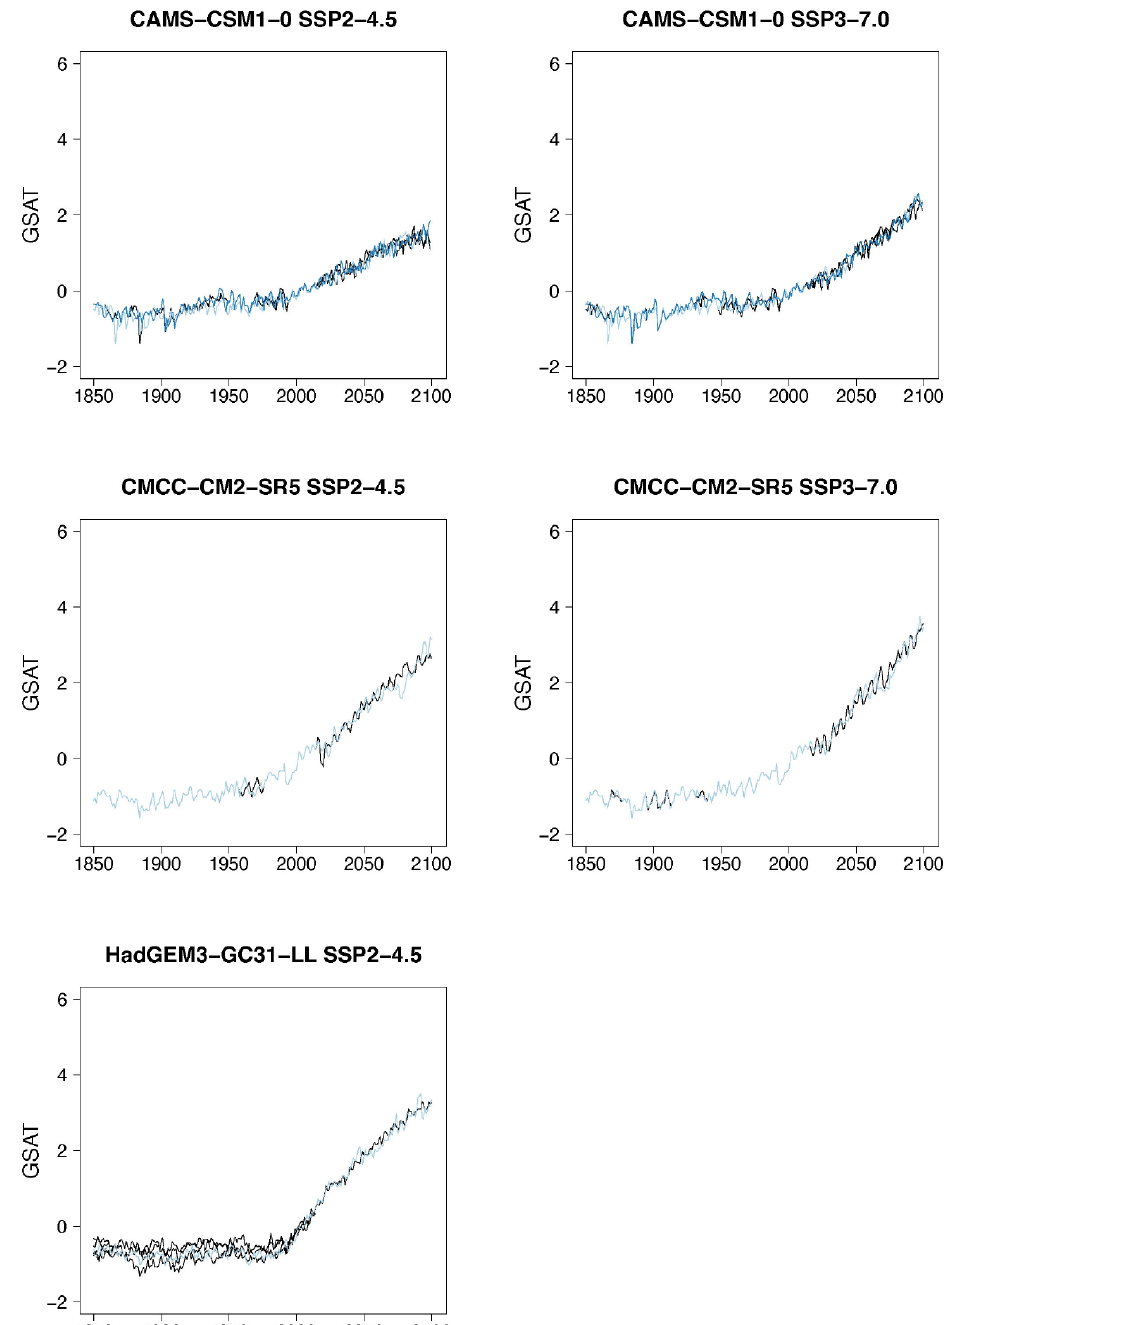
Figure B5. Examples of target (black lines) and stitched (colored) GSAT time series for ESMs in the PANGEO archive that ran at least one trajectory along the Tier 1 experiments of ScenarioMIP (SSP1-2.6, SSP2-4.5, SSP3-7.0, SSP5-8.5). We use the two bracketing scenarios and emulate trajectories that follow the two intermediate